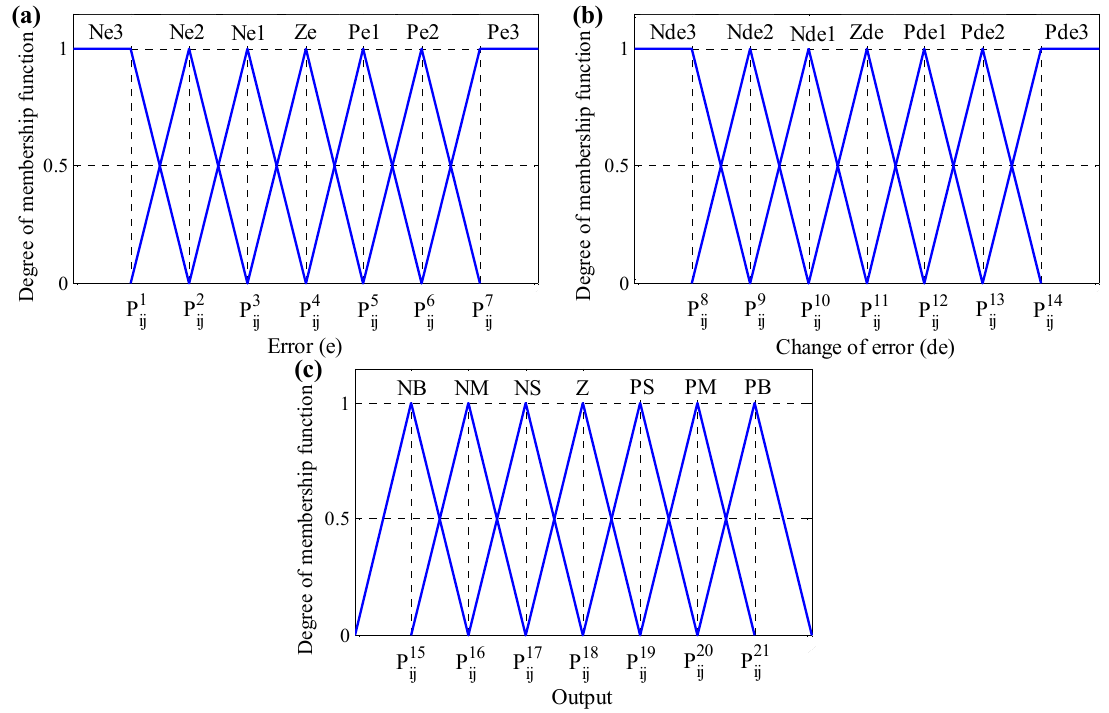
Figure 4. MFs for: ( a ) error; ( b ) change of error; ( c ) output.